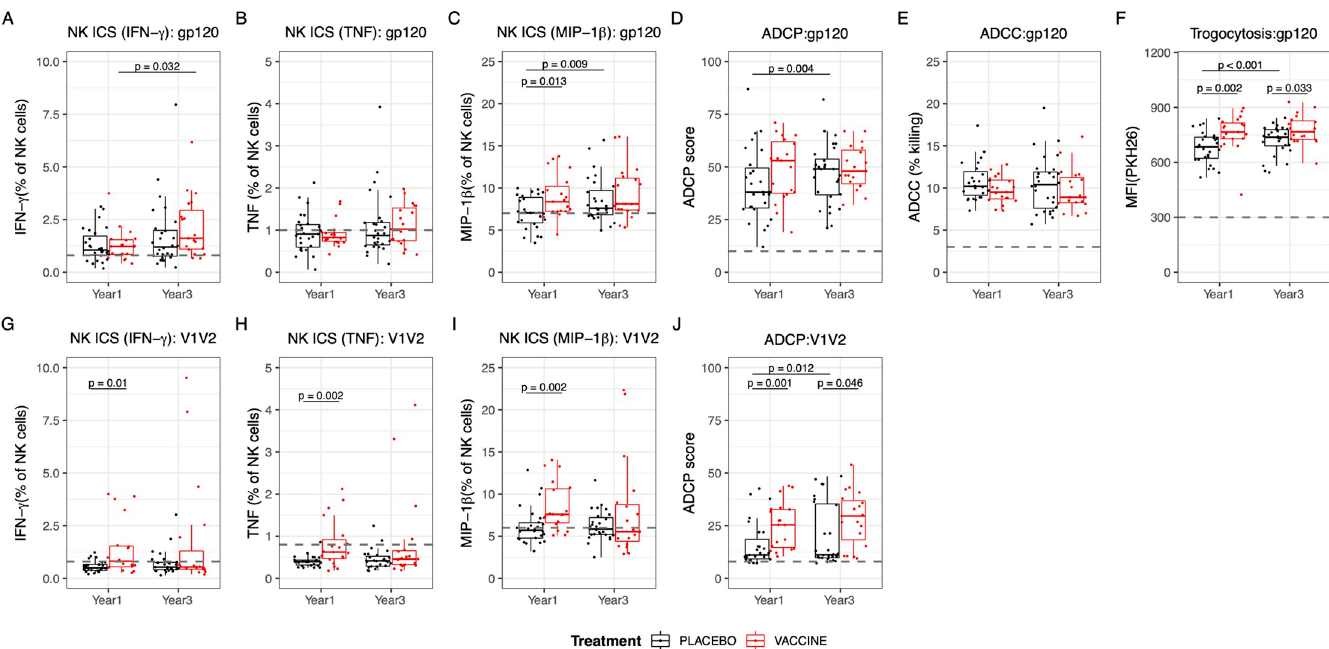
Fig 5. Vaccine recipients demonstrated increased Fc effector functions to V1V2 1 year after HIV-1 diagnosis. Vaccine recipients are represented in red and placebo recipients in black. (A to J) Fc effector function assays to gp120 AE 244 (A-F) or gp70 V1V2 92TH023 (G-J) antigens using year 1 and year 3 samples from vaccine and placebo recipients. Differences in Fc effector function between each group were assessed by NK cell activation (expression of IFNg (A,G), TNF (B,H), or MIP-1b (C,I)), ADCP (D,J), ADCC (E), and trogocytosis (F). The black dashed line represents the positive cut-offs, which were calculated based on two negative controls. Groups were compared using Mann-Whitney U tests, and differences between year 1 and year 3 within the vaccine or placebo groups were calculated using Wilcoxon signed rank test (N = 19 vaccine, 28 placebo). Only significant ( < 0.05) p values are shown.